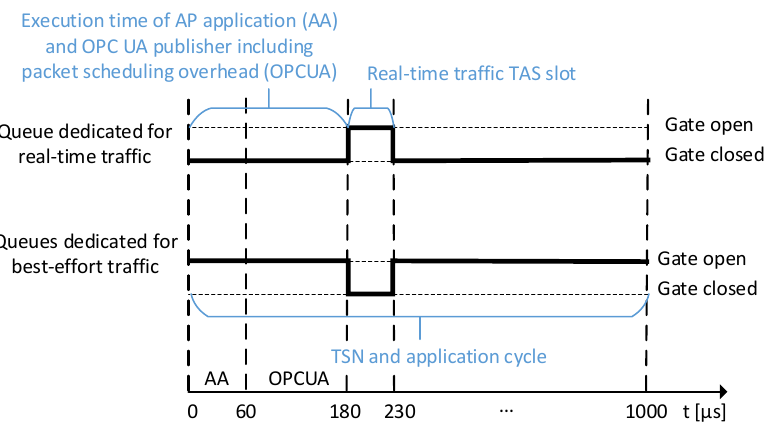
Figure 17. Time-Sensitive Networking and application cycle of the AUTOSAR